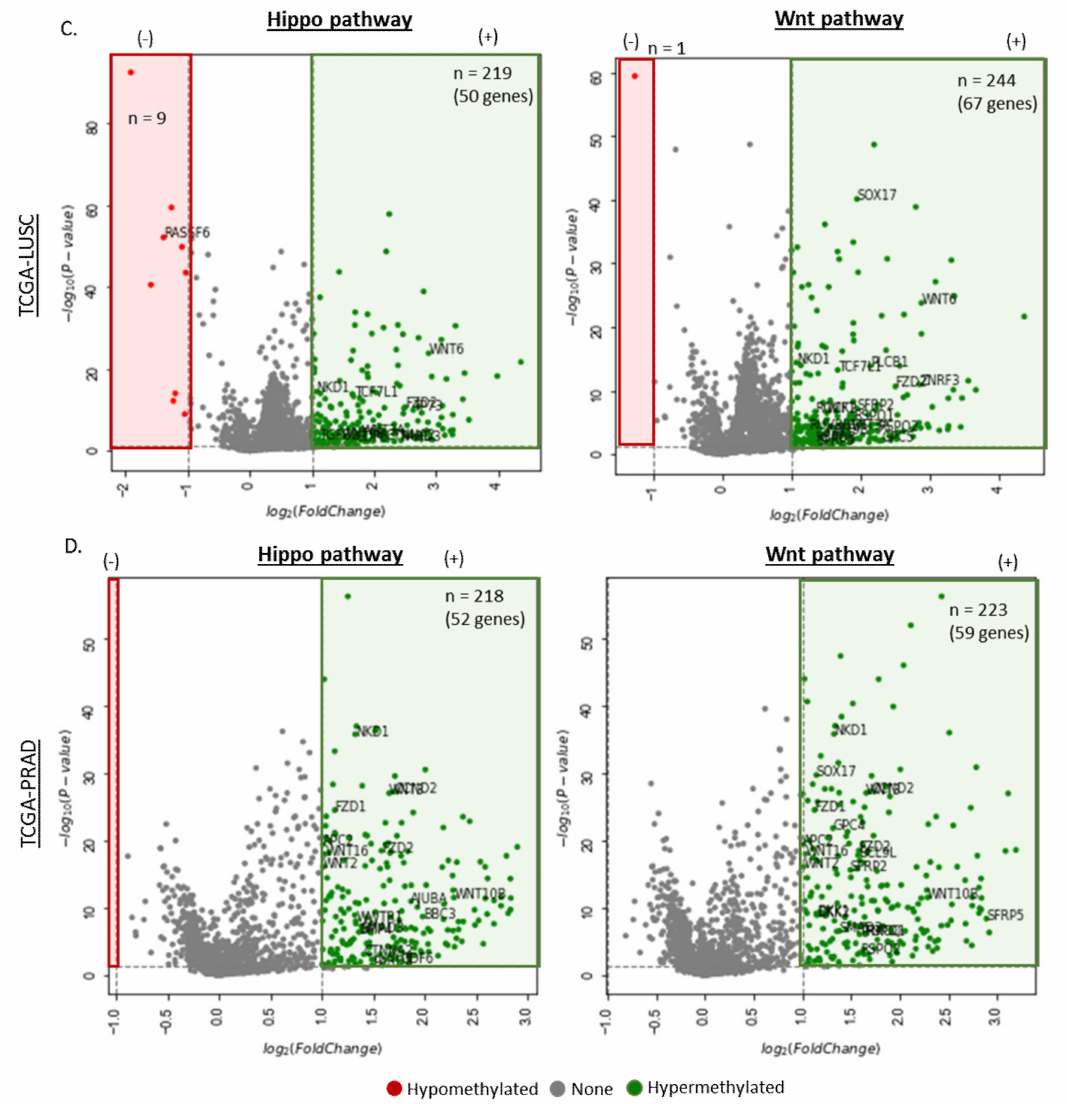
Figure 3. Volcano plots for di ff erential DNA methylation in four di ff erent cancers in the Hippo and Wnt pathways. The x-axis is log 2 fold change of DNA methylation (beta values), whereas the y-axis shows the –log 10 of the p values for each CpG site representing the strength of the association. Each point represents a CpG site. Dashed lines indicated cuto ff s for significance, where p < 0.05 and log 2 (Fold Change) < − 1 (hypomethylation) or > 1 (hypermethylation). Changes in methylation of CpG island-associated CpG sites are shown for Hippo (left) and Wnt (right) pathway-related CpG sites where ( A ) TCGA-BRCA (n tumor = 785, n normal = 95), ( B ) TCGA-COAD (n tumor = 313, n normal = 38), ( C ) TCGA-LUSC (n tumor = 370, n normal = 42), and ( D ) TCGA-PRAD (n tumor = 502, n normal = 50), where the number of hypermethylated CpGs in each cancer type is shown in green, and the number of hypomethylated CpGs in each cancer type is shown in red. The number of hypermethylated CpGs and number of corresponding genes is also